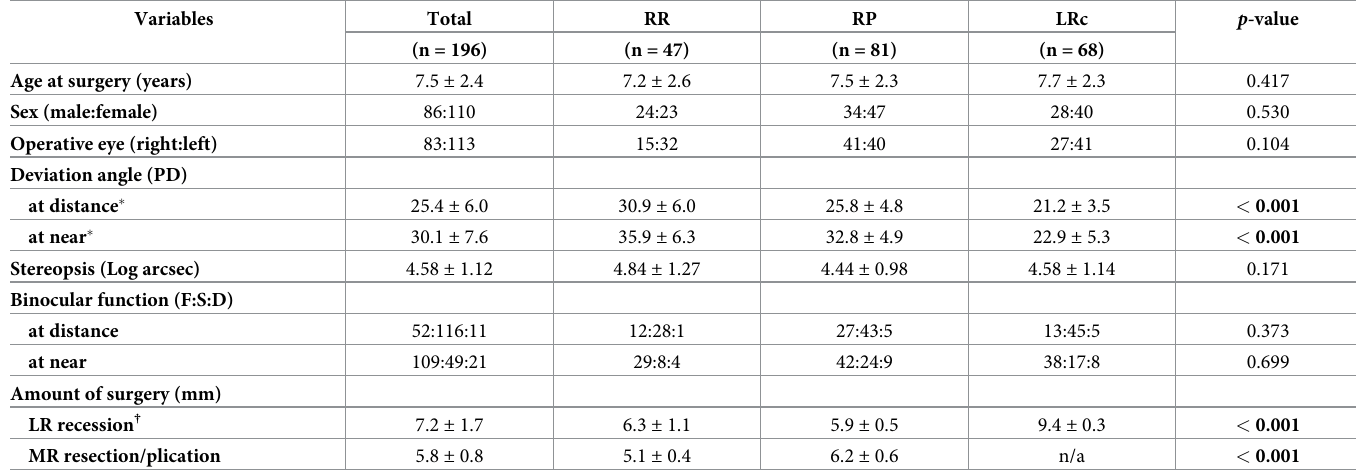
The baseline demographic and clinical data are summarised in Table 2. The mean age at sur- gery was 7.5 ± 2.4 years, and 56.1% of the patients were female. The deviation angle of the RR Table 2. Baseline demographic data and clinical characteristics of the study